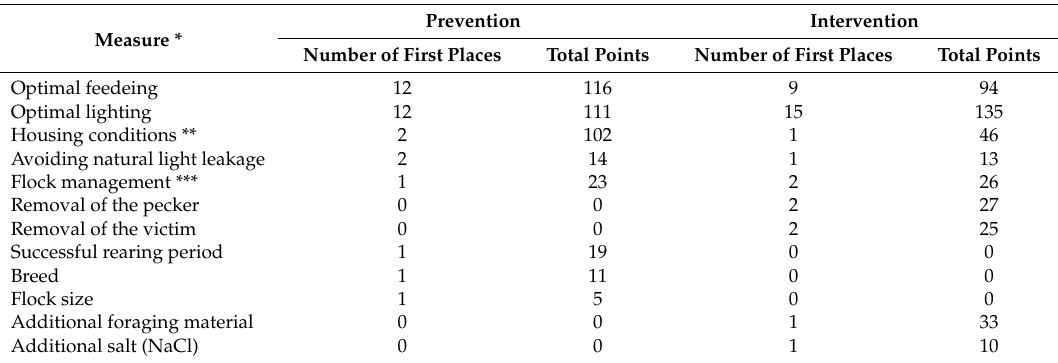
Table 4. The most important methods to prevent pecking problems and intervention measures to manage an ongoing pecking problem, according to Finnish egg producers. Measure